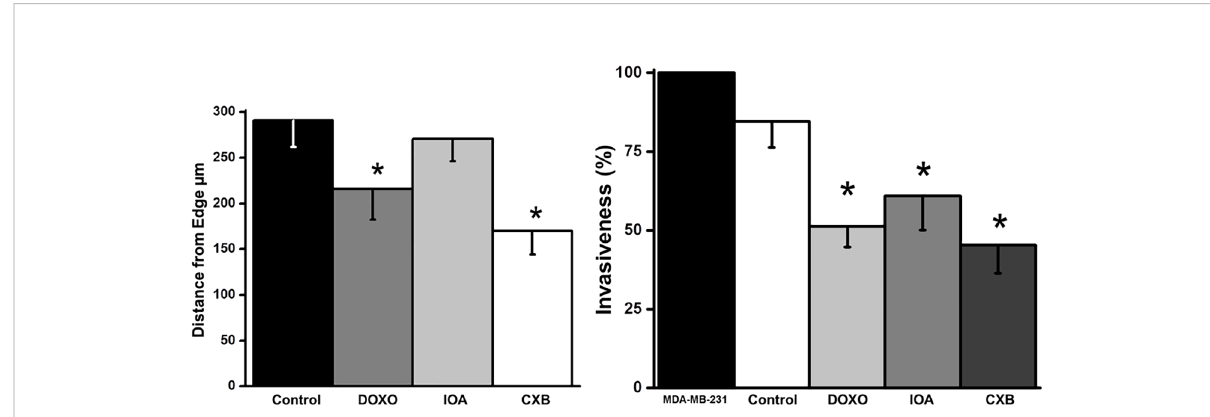
FIGURE 7 Effect of celecoxib (CXB), doxorubicin (DOXO) and iodoacetate (IOA) on migration and invasiveness of cells derived from MCF-7 MCTS. Drugs were added as it was indicated in the Material and Methods section at IC50 concentrations reported in Table 1. Data shown represent the mean ± S.D. of at least three different preparations. *P <0.05 vs. control (non-treated